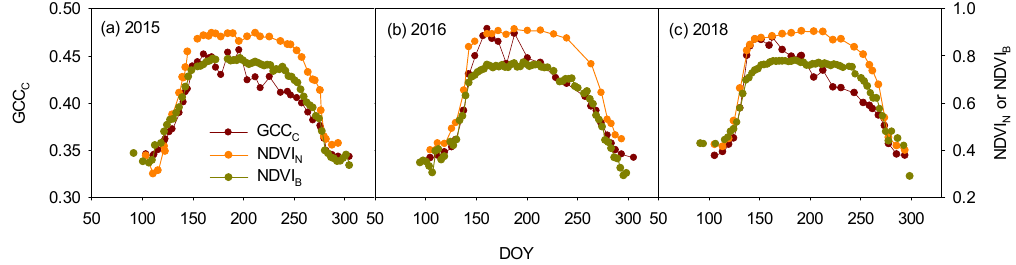
Figure 4. Seasonal variations in the vegetation indices measured with the three types of sensor in 2015 ( a ), 2016 ( b ), and 2018 ( c ). GCC C : green chromatic coordinate from camera, NDVI N : narrowband normalized di ff erence vegetation index from spectroradiometer, NDVI B : broadband normalized di ff erence vegetation index from routine radiometer. DOY: the day of year. The GCC C and NDVI N are the mean values of four azimuths with an inclination-angle of 30°. The NDVI B is calculated by routine radiometer with an inclination-angle of 90 °. Table 6. Differences (number of days, mean ± 95% confidence interval) in phenophases between different sensors.